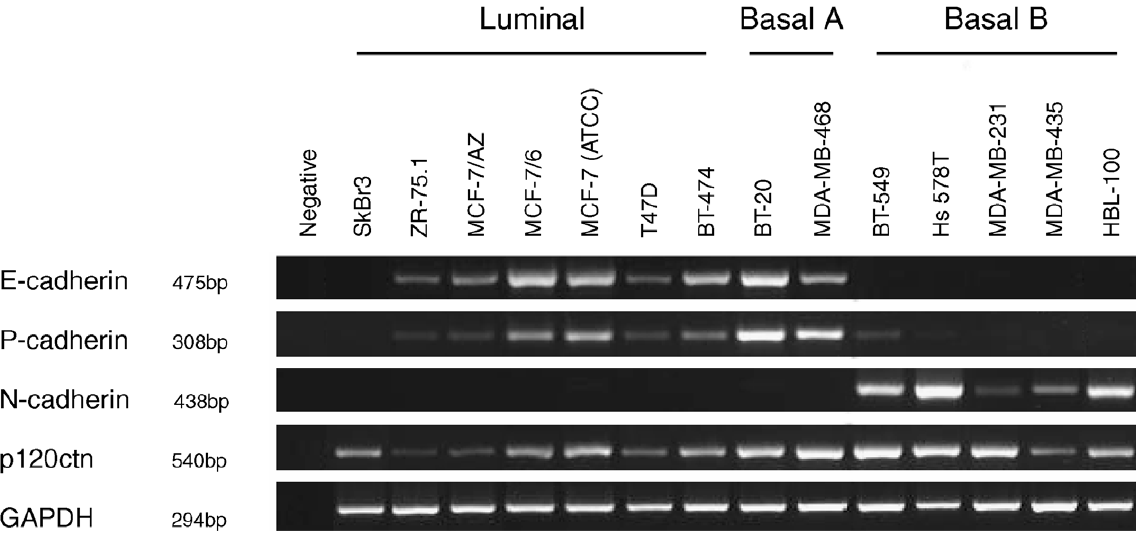
Fig. 2. Expression profile of E-, P- and N-cadherin and total p120ctn transcripts of breast cancer cell lines, analysed by RT-PCR. The different fragment sizes are indicated on the left. GAPDH expression was used as internal